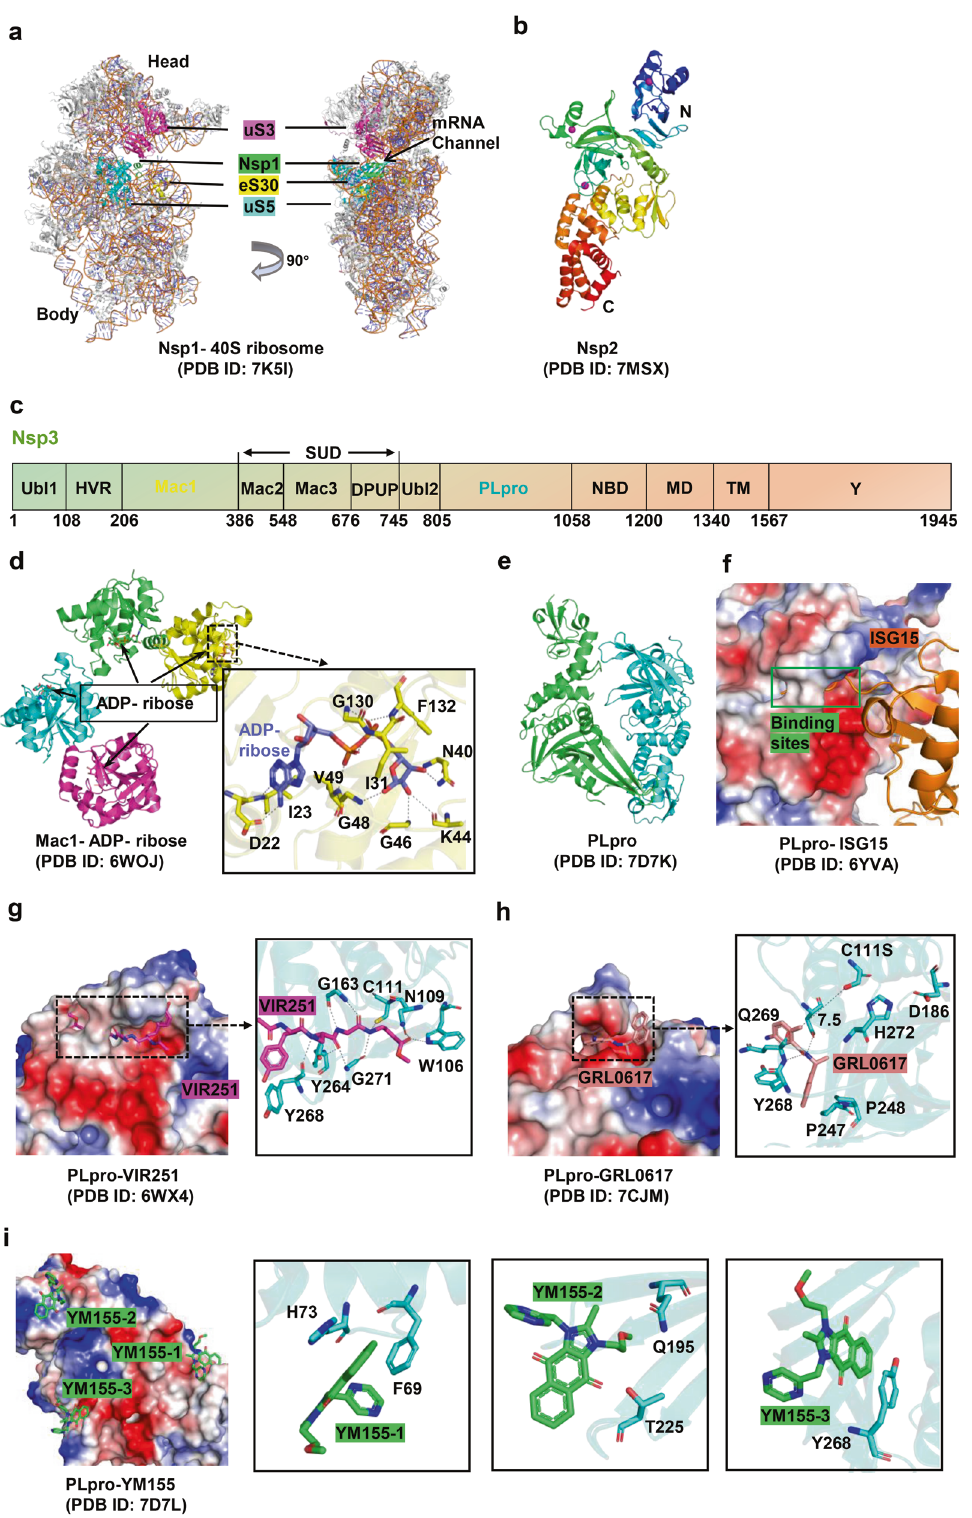
Fig. 4 Structures of Nsp1 /Nsp2 /Nsp3 and their inhibitors. a Structure of Nsp1 in complex with 40 S ribosome. Nsp1 binds at the mRNA channel in the cleft between the head and body of the 40 S ribosome. b Overall structure of Nsp2 protein. c Schematic representation of Nsp3 protein ’ s domain. d Structures of Mac1 domain in complex with ADP ribose. e, f Structure of apo PLpro and its complex with interferon- stimulated gene 15 protein (ISG15), respectively. g – i Structures of PLpro in complex with different inhibitors (VIR251, GRL-0617, and